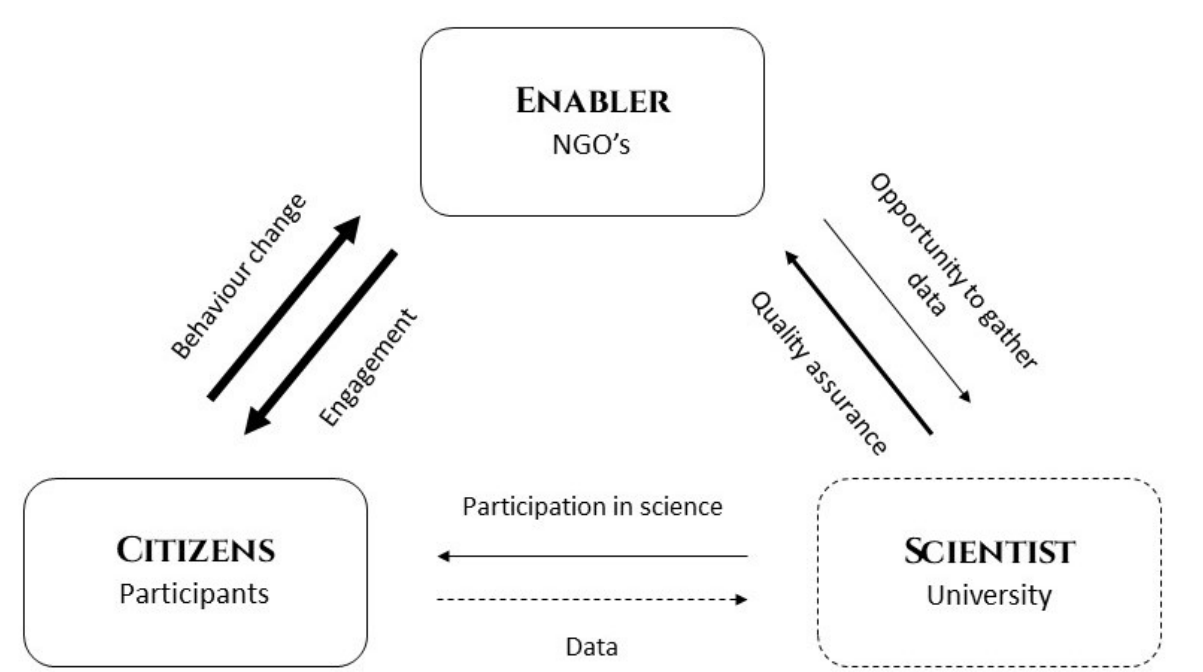
Figure 2. The tripartite model of citizen science applied to the Great Kerer¯u Count 2014–2015. Line thickness indicates strength of the provided service. Dashed line indicates slim-to-no service provided. Boxes indicate different roles that individuals might occupy. The project was initiated by two NGOs. Although data was being gathered, scientists were not explicitly part of the initial project formulation.